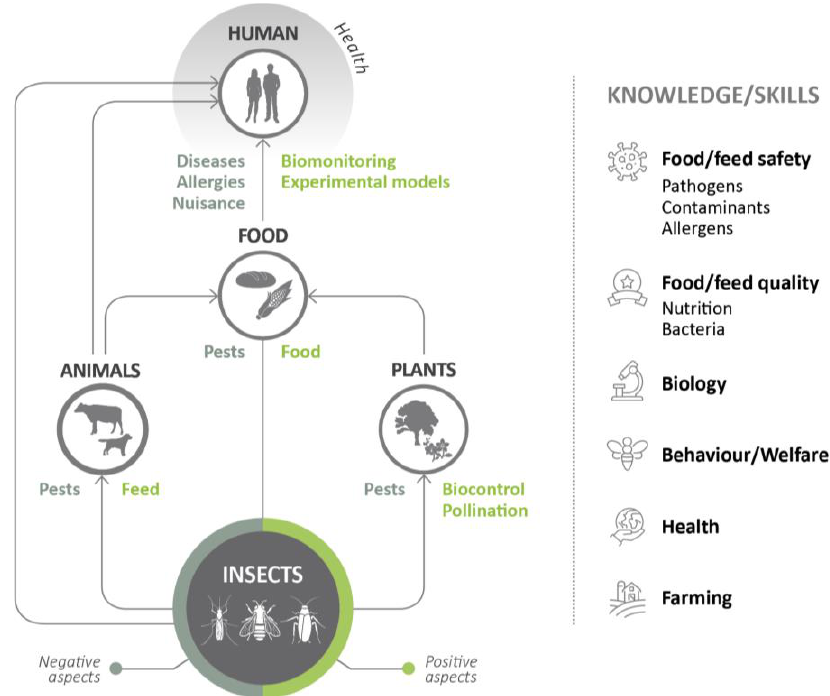
Figure 1. Positive (green) and negative (grey) relationships between insects with respect to contexts with public health implications.